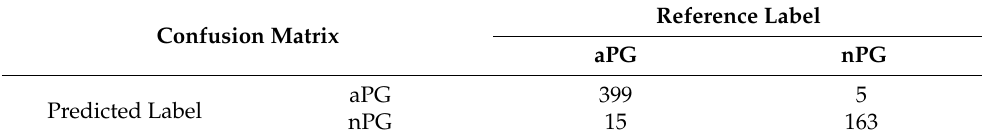
Table 3. Confusion matrix.